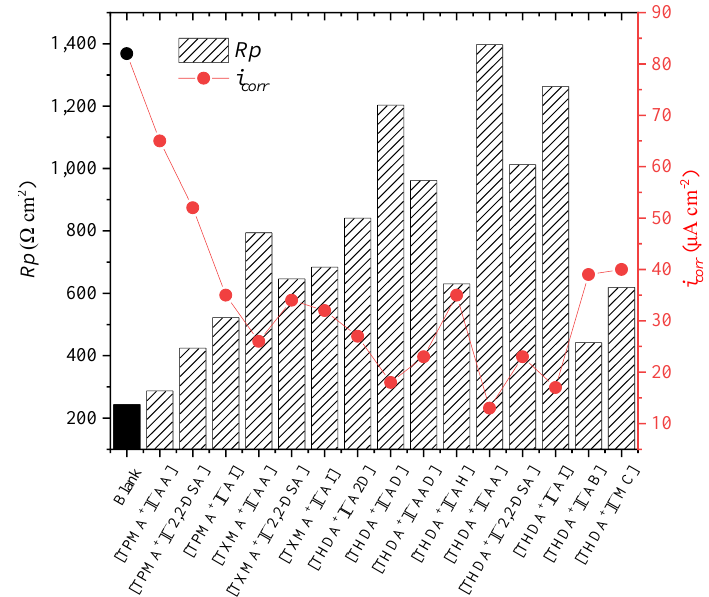
Figure 1. Rp and i corr values of API X52 steel in 0.5 M HCl and ILs at 100 ppm by the Rp- and Tafel-polarization techniques, respectively.